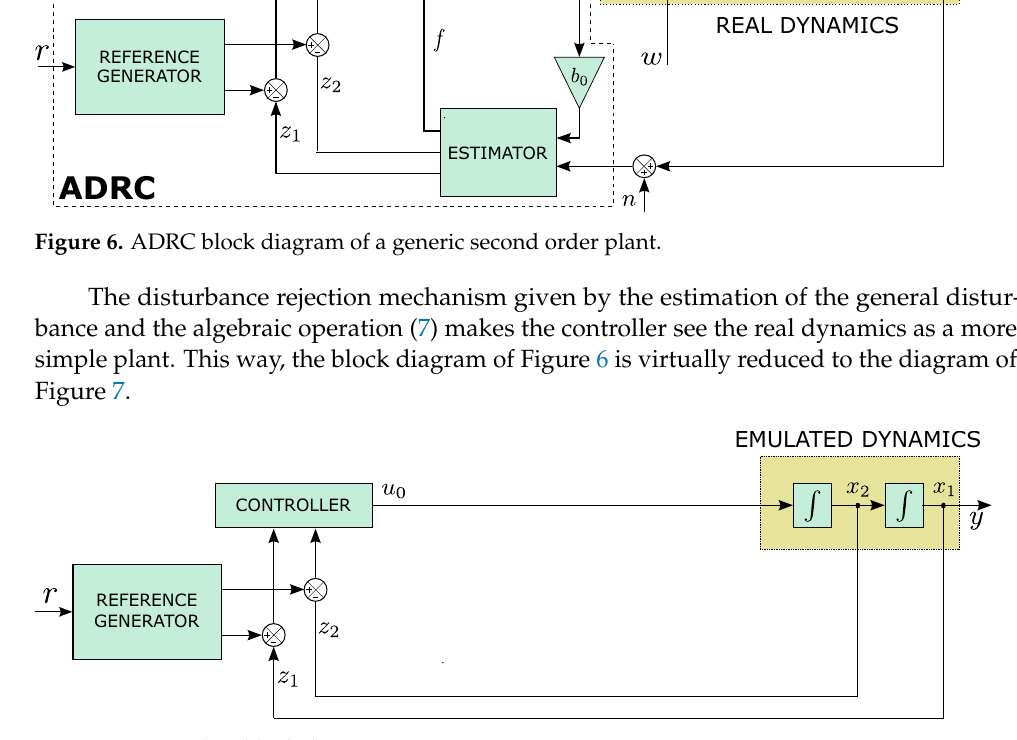
Figure 7. Equivalent block